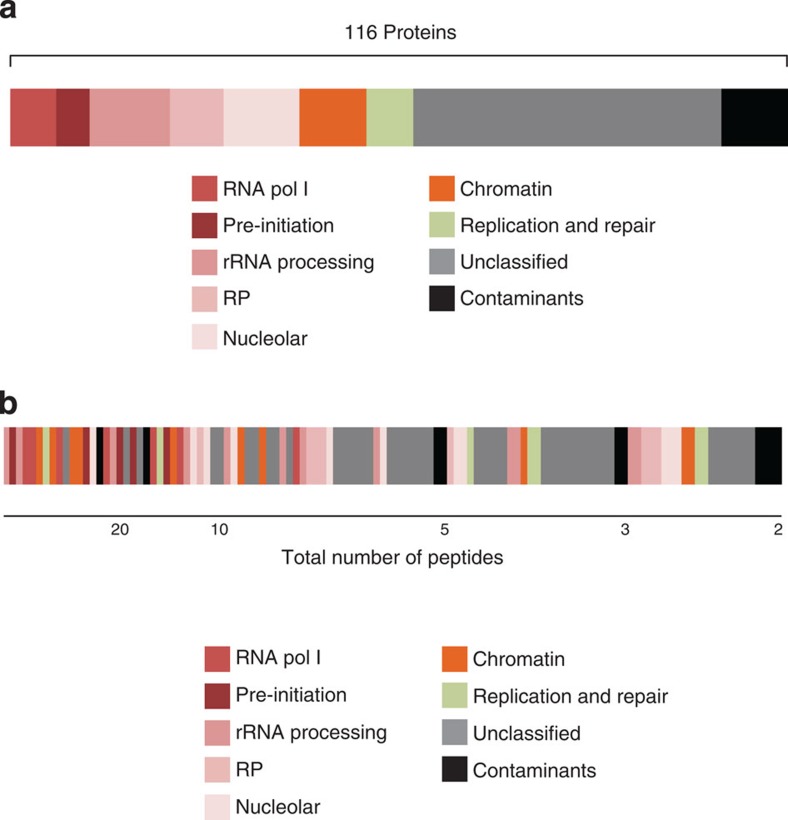
rDNA gene promoter chromatin proteome.(a) Categorization of the 116 proteins enriched in ePICh with both RDN6 and RDN23 into nine functional groups: specific subunits of the RNA polymerase I core complex (RNA pol I), Pre-initiation complex for pol I transcription (pre-initiation), ribosomal RNA processing and modification proteins (rRNA processing), ribosomal proteins (RP), proteins localized in the nucleolus (Nucleolar protein), chromatin regulatory protein (Chromatin), proteins involved in DNA replication and repair (Replication and Repair), unclassified proteins (Unclassified), streptavidin and mitochondria proteins (Contaminants). (b) List of proteins enriched at the rDNA promoter according to the number of identified peptides and arranged in descending order. Scale bars (in peptide number) are shown below.